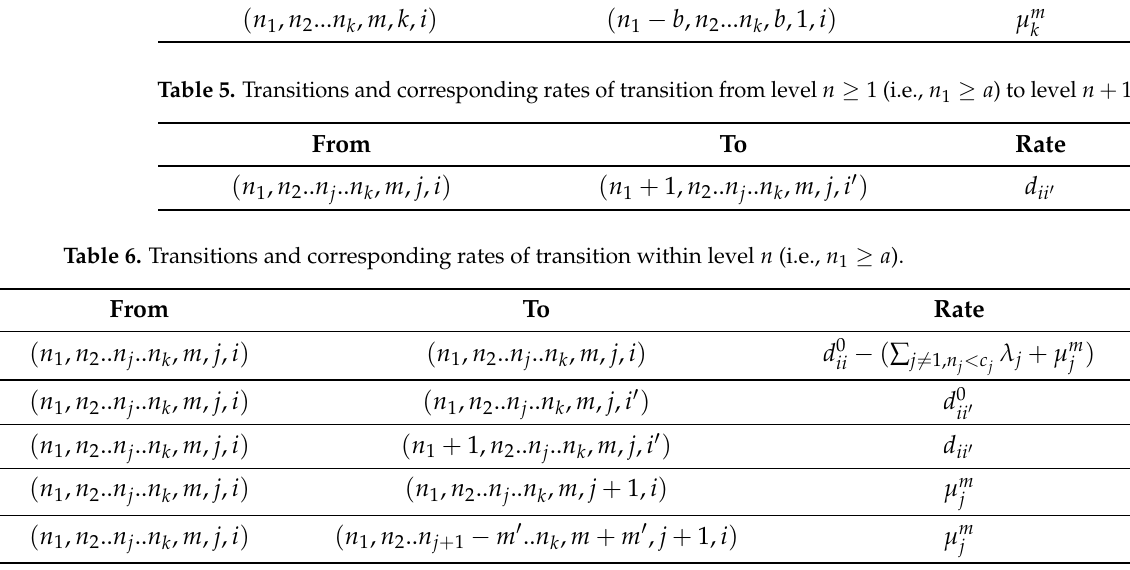
Table 4. Transitions and corresponding rates of transition from level n (i.e., n 1 ≥ b ) to lower levels From To